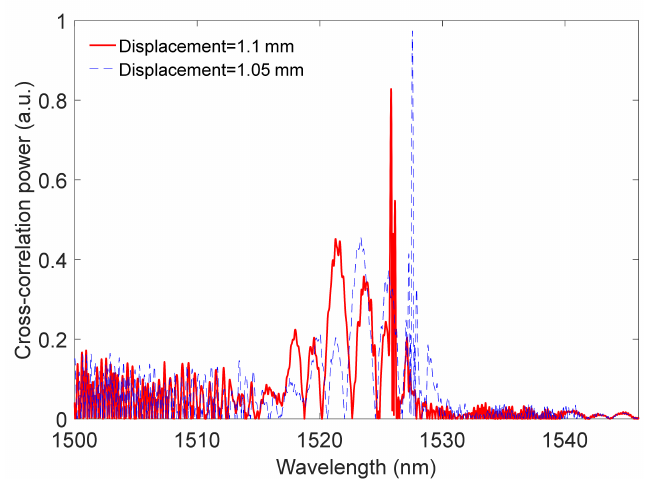
Figure 6. The cross-correlation curves under a displacement of 1.05 mm (blue dot line) and 1.1 mm (red line).